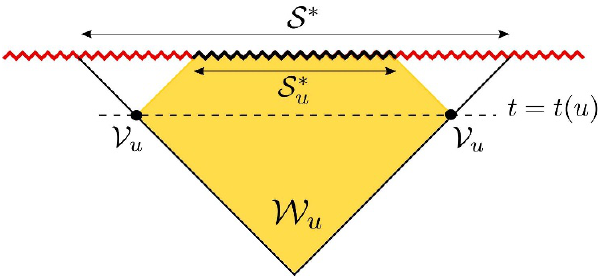
Figure 14 . WdW patch for a Kasner slab S ∗ u